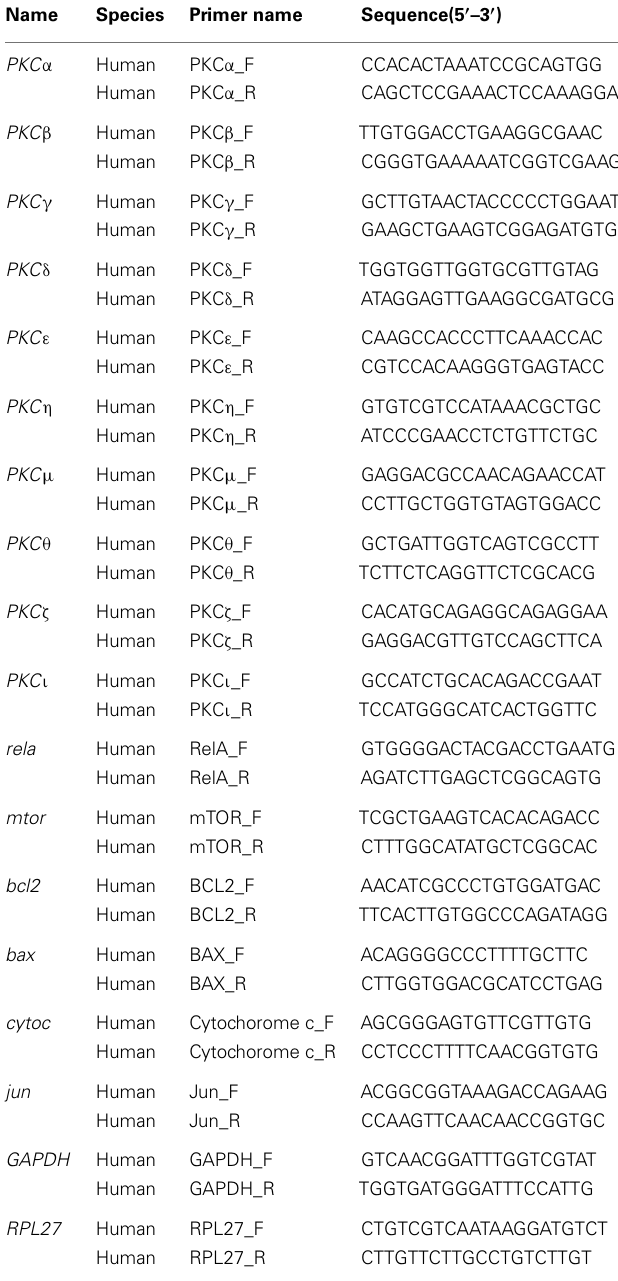
Table 1 | List of primer sequences for qRT-PCR